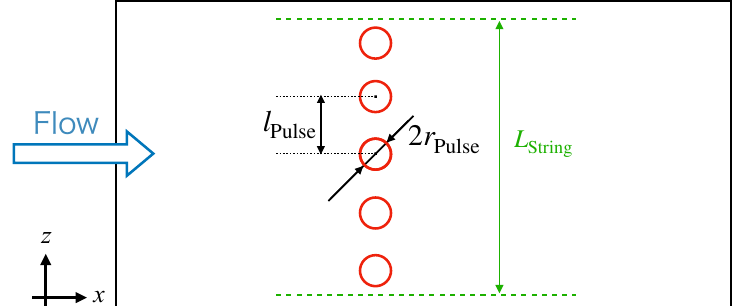
Figure 7. Model of plasma beads.